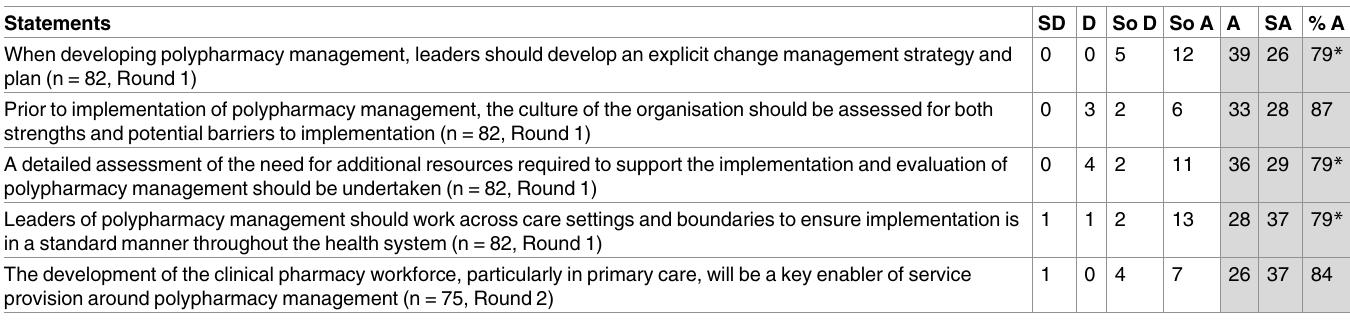
Table 5. Number of responses and % agreement(strongly agree/agree) to statements relating to change